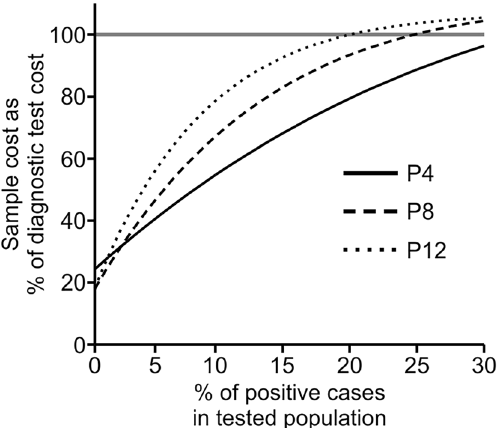
Figure 4. Economics of screening test. Comparative costs of testing using epidemic pooling tests and individual diagnostic tests employing a one-step, multiplex RT-qPCR SARS-CoV-2 commercial kit. Data are normalized against the cost of individual testing using commercial diagnostic tests (100%, horizontal line) and for both methods include the cost of reagents, disposable, PPE, labor, laboratory equipment and overheads. P4, P8, P12: pooling factors (number of individual samples within a